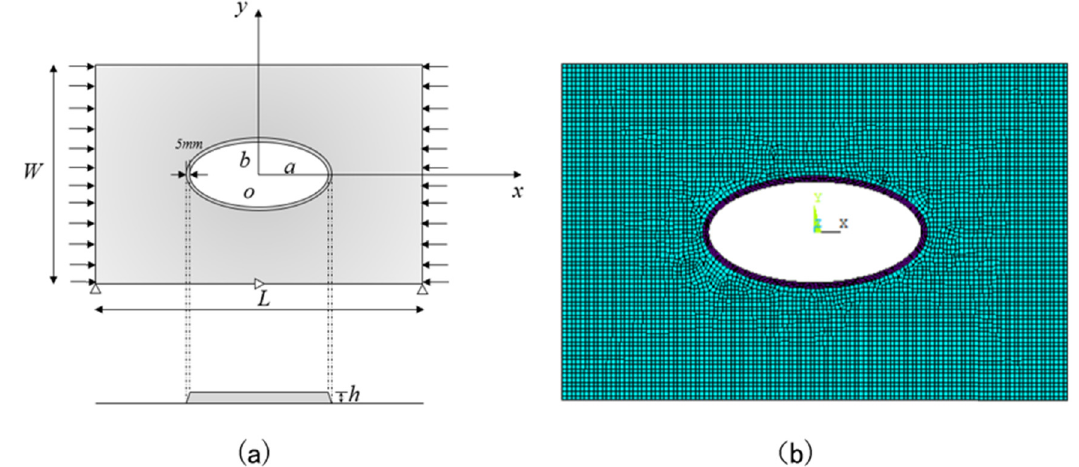
Figure 2: A plate with hyper - ellipse fl anged cutout ( a ) and its fi nite element model ( b )